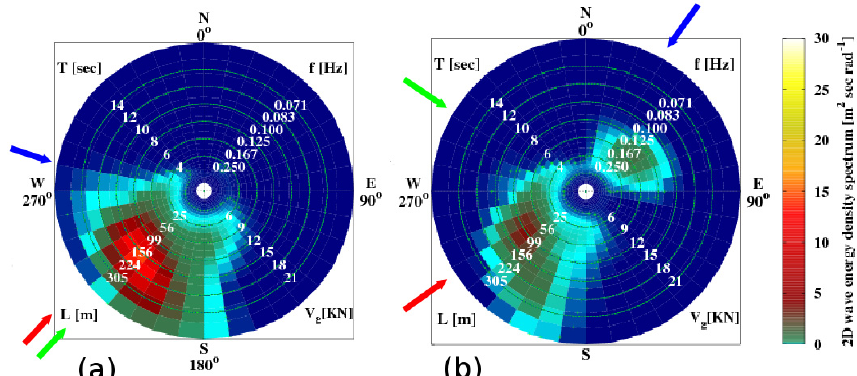
Figure 5. Wave energy spectrum for ww3 model at XXM buoy location. Color is proportional to wave energy (m 2 srad − 1 ). Blue arrow indicates the mean wind direction, green arrow the mean wave direction and red arrow the wave peak direction. Left panel (a) valid for 00:00UTC on 2 January 2010 (sea-storm phase 2). Right panel (b) valid for 15:00UTC on 2 January 2010 (sea-storm phase 3).